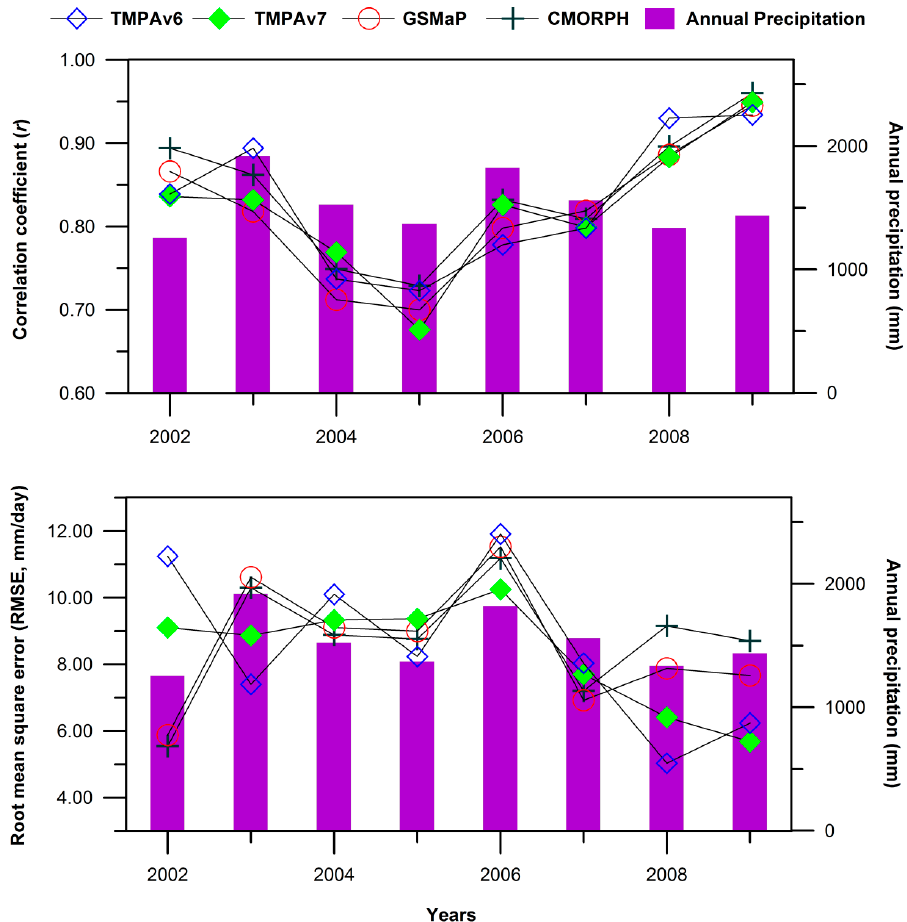
Figure 2. Yearly correlation and root-mean-square error (RMSE) values between basin-averaged precipitation from TMPA version 6 (TMPAv6), TMPA version 7 (TMPAv7), GSMaP, CMORPH and gauged estimates over the Soyang dam basin ( x axis). Each bar represents annual basin-averaged precipitation from 19 weather stations ( y axis).